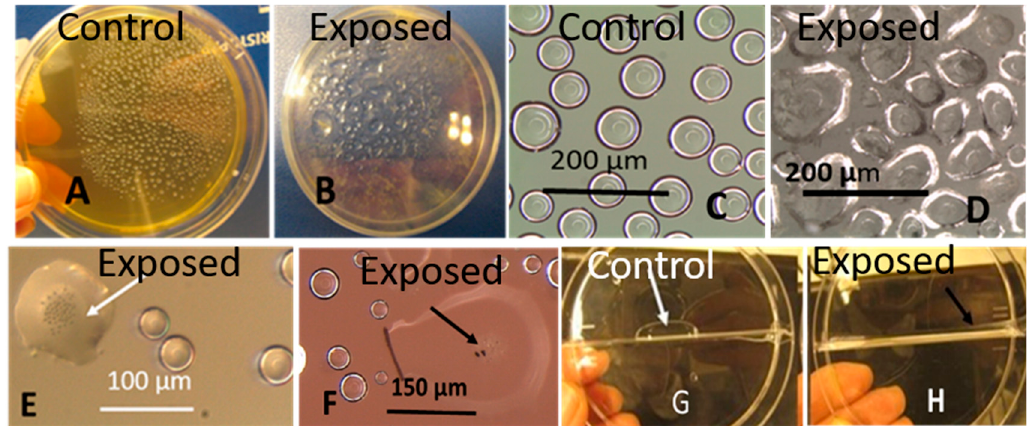
Figure 9. Surfactant activity of fungal exudates and conidia viewed by naked eye ( A , B , G , H ) and stereomicroscope ( C – F ). The figure shows liquid droplets condensed on the inner surface of the plastic Petri plate lid above fungal cultures incubated for 2 weeks on malt extract agar ( A – F ). Panels ( G , H ) show tap water droplets of 500 µL on a ventilation cam of a two-compartment Petri dish. The controls exhibit the liquid droplets with an undisturbed surface tension above a non-inoculated agar plate ( A , C ) and on the ventilation cam ( G ). Flat, enlarged, irregular droplets exposed for 2 weeks to fungal metabolites above a plate with a T. atroviride culture (strain T1/SKK) are shown in Panels ( B , D ). Flat, enlarged droplets containing conidia emitted by T1/SKK (white arrow) and of Stachybotrys sp. strain HJ5 (black arrow) are shown in Panels ( E , F ). Panel ( H ) shows the surface enlargement (black arrow) of the control droplet in Panel ( G ) (white arrow) after addition of 50 µL exudate from Rhizopus sp. strain MKA1.